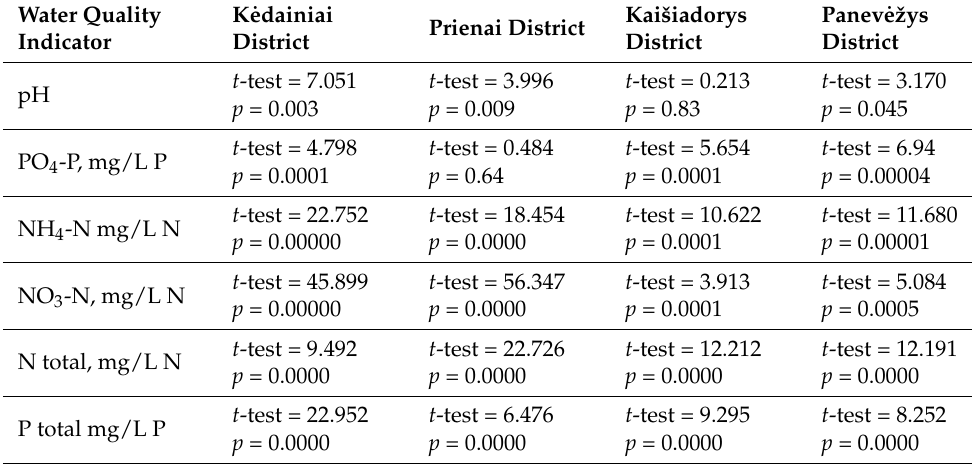
Table 2. Differences between the values of water quality indicators in the areas of organic and intensive agricultural